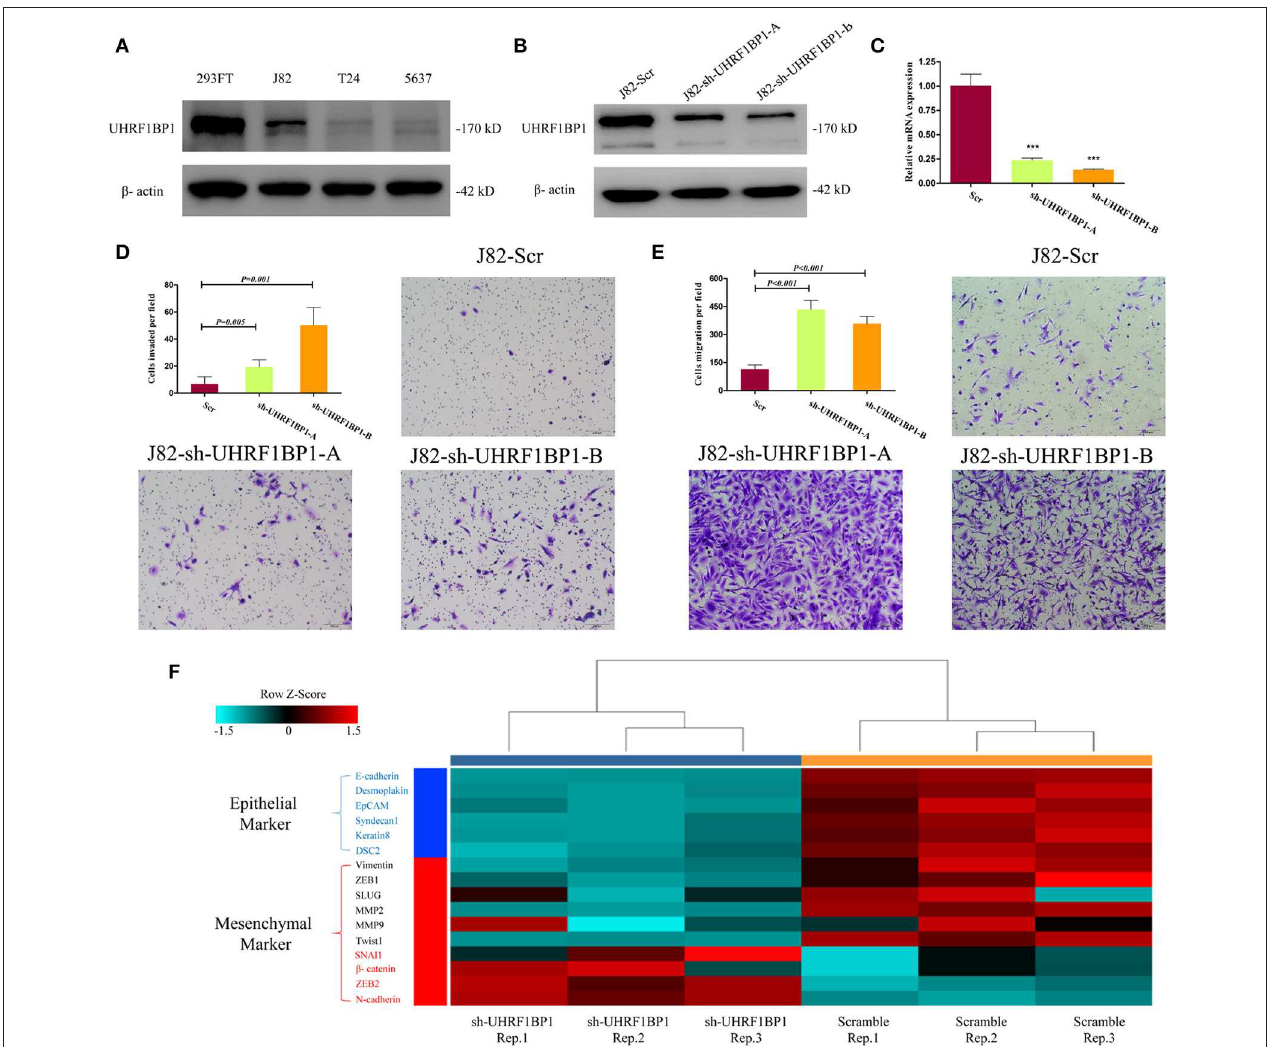
FIGURE 4 | Down-regulation of UHRF1BP1 in J82 cell line can promote cell migration and invasion. (A) UHRF1BP1 is relatively highly expressed in J82 bladder cancer cell line, β -actin as a loading control. HEK293FT cell line acts as a positive control. (B) UHRF1BP1 protein expression is significantly inhibited by sh-UHRF1BP1-A&B. (C) UHRF1BP1 mRNA level is significantly inhibited by sh-UHRF1BP1-A&B. (D) . Representative images of invasion assay for J82 cells infected by scramble and sh-UHRF1BP1-A/B lentiviruses. (E) Representative images of migration assay for J82 cells infected by scramble and sh-UHRF1BP1-A/B lentiviruses. (F) Heatmap shows the mRNA expression differences of 16 genes involved in EMT between J82-Scr cells and J82-sh-UHRF1BP1-B cells in triplicates. This PCR array includes six epithelial markers (blue) and 10 mesenchymal markers (red). *** P <